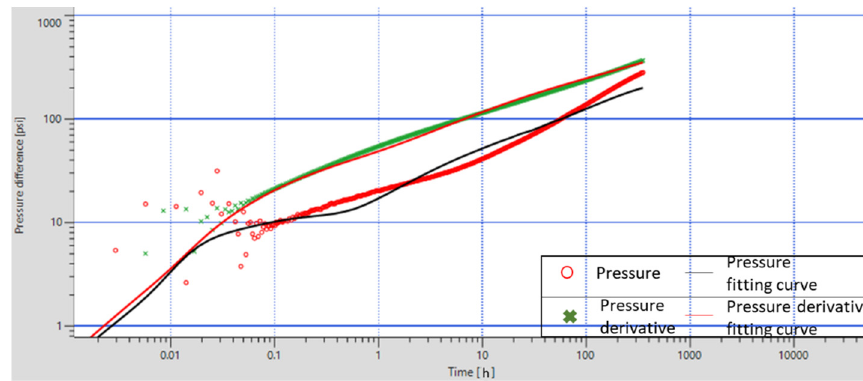
Figure 17. 9 ‐ 5H well test curve. Figure 17. 9-5H well test